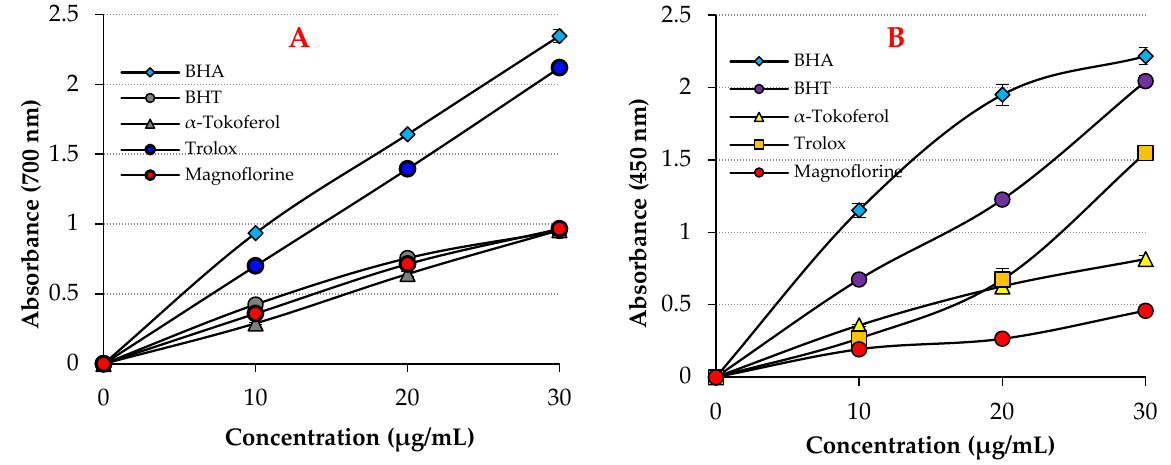
Figure 1. Fe 3+ ( A ) and Cu 2+ ( B ) ions reducing abilities of Magnofluorine and standards. The Cu 2+ reduction ability of Magnofluorine and the positive controls (30 μ g/mL) is